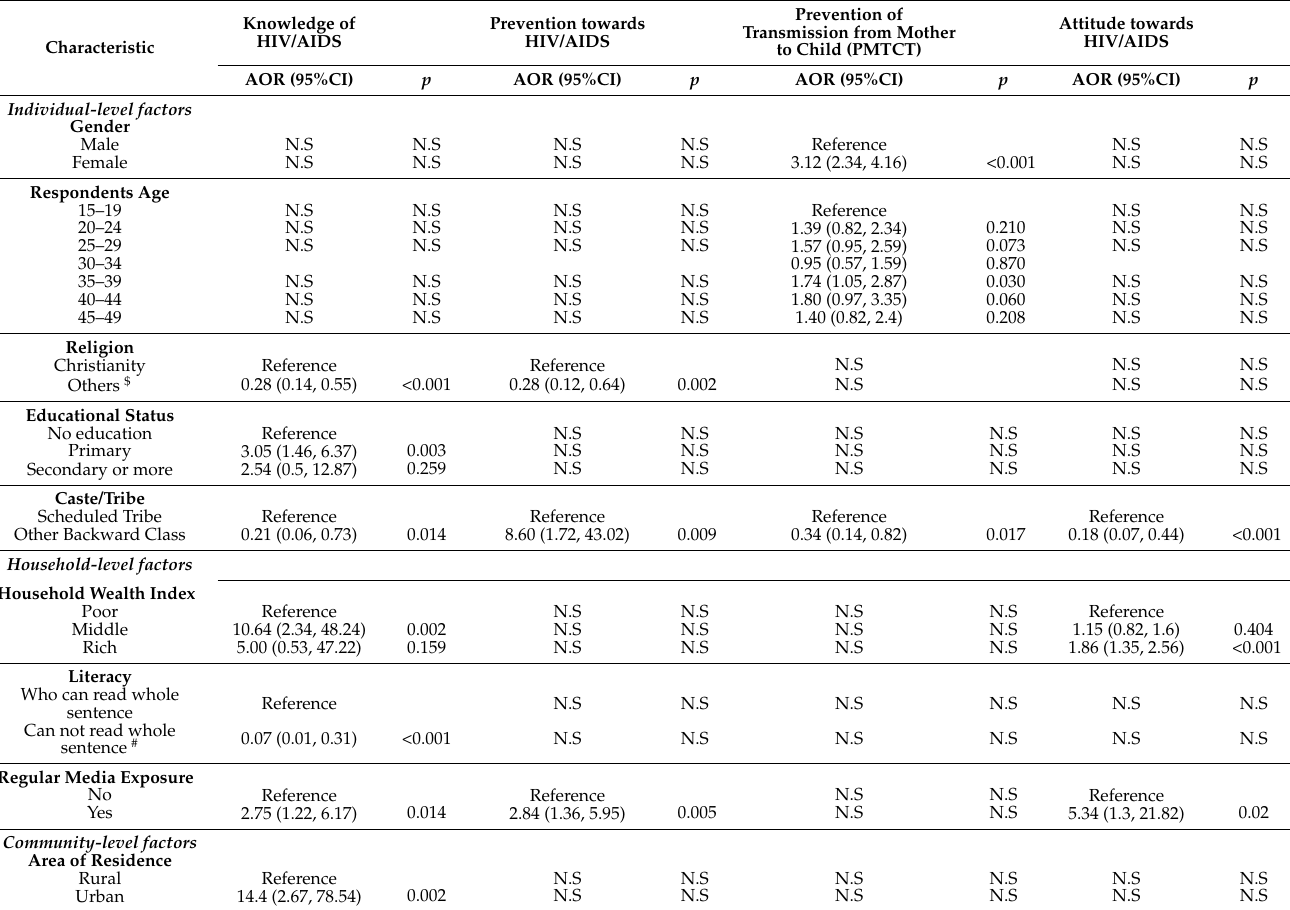
Table 4. Adjusted Odds ratios (95% confidence intervals) for respondents’ knowledge, attitudes, and prevention towards HIV/AIDS: a multivariate